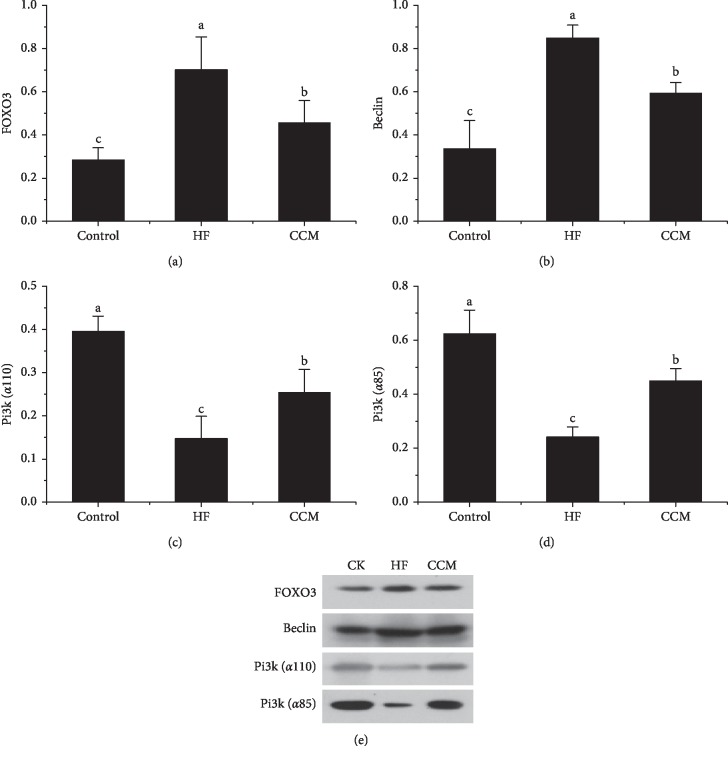
Effects of cardiac contractility modulation (CCM) on FOXO3, Beclin, Pi3k(α110), and Pi3k(α85) expression in different rabbit myocardial tissues under different treatments. (a) FOXO3 expression; (b) Beclin expression; (c) Pi3k(α110) expression; (d) Pi3k(α85) expression; and (e) western blot images of FOXO3, Beclin, Pi3k(α110), and Pi3k(α85). CK, control group; HF, heart failure. Different lower letters above each boxplot showed the significant differences at p < 0.05.